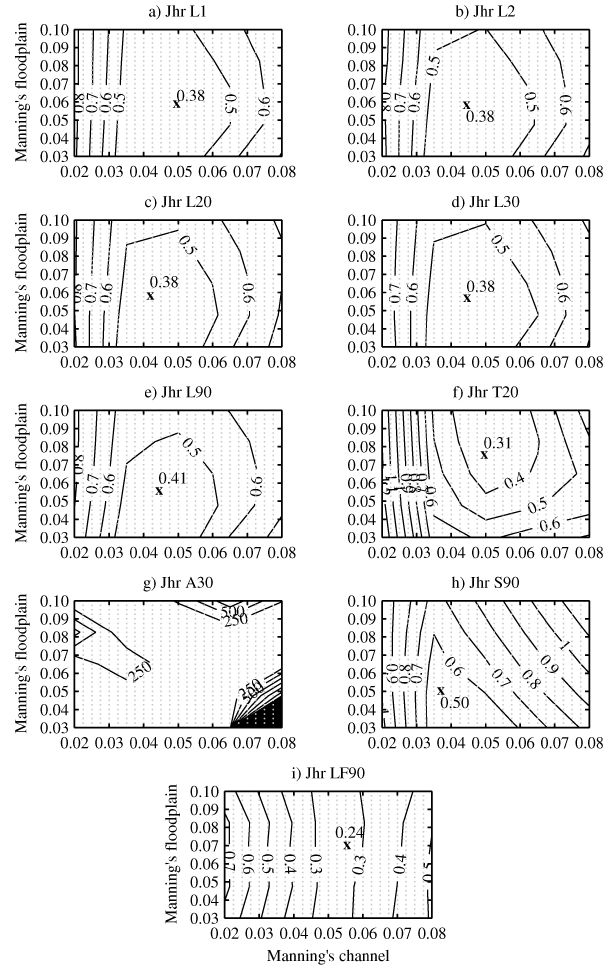
Figure 4. Model calibration: contour maps of MAE across the pa- rameter space for (a–h) eight different 1-D models (HEC-RAS) and (i) for the 2-D model (LISFLOOD-FP).